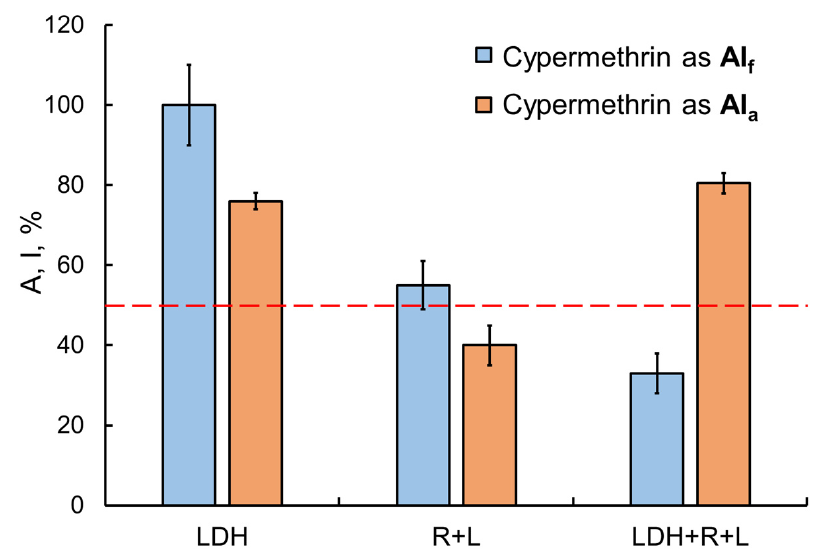
Figure 6. Comparison of the effects of the Briz commercial pesticide formulation (with cypermethrin as the active ingredient) and cypermethrin as AIa on enzyme assay systems with different lengths of the enzyme conjugation chain. Cypermethrin concentration was 2 mg/L. The inhibitory effects of cypermethrin as AIf were enhanced by elongation of the chain of conjugated enzyme reactions. No such dependence, though, was found for cypermethrin as AIa.